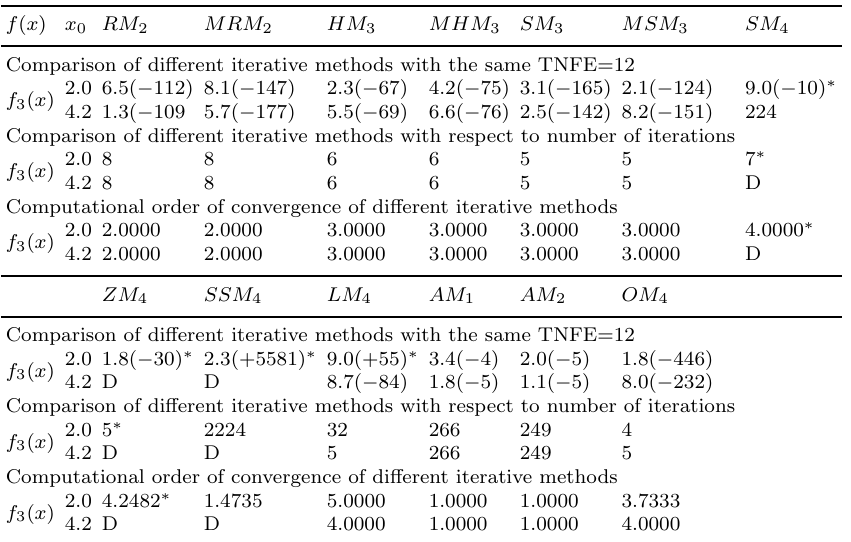
Table 5. Test problem (6.3)